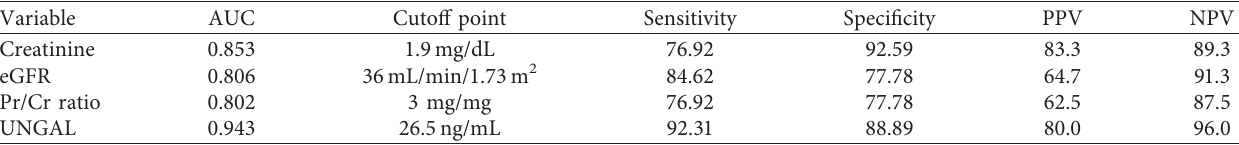
Table 5: Cutoff levels for baseline UNGAL and conventional biomarkers in predicting renal response to